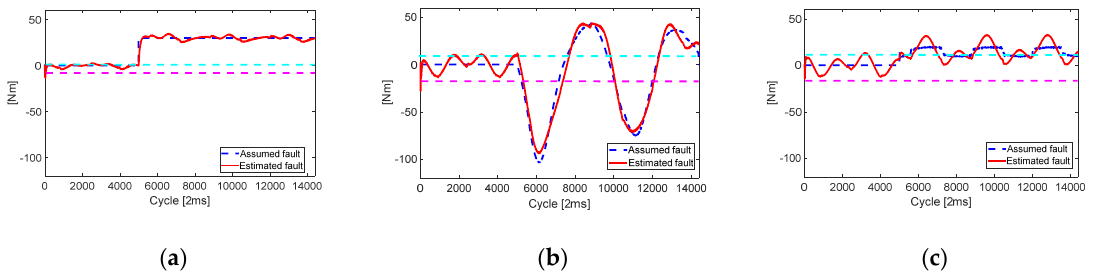
Figure 13. Fault estimation results with multiple faults. The aqua and pink dashed lines are upper and lower thresholds, respectively. ( a ) Joint 1; ( b ) Joint 2; ( c ) Joint 3.